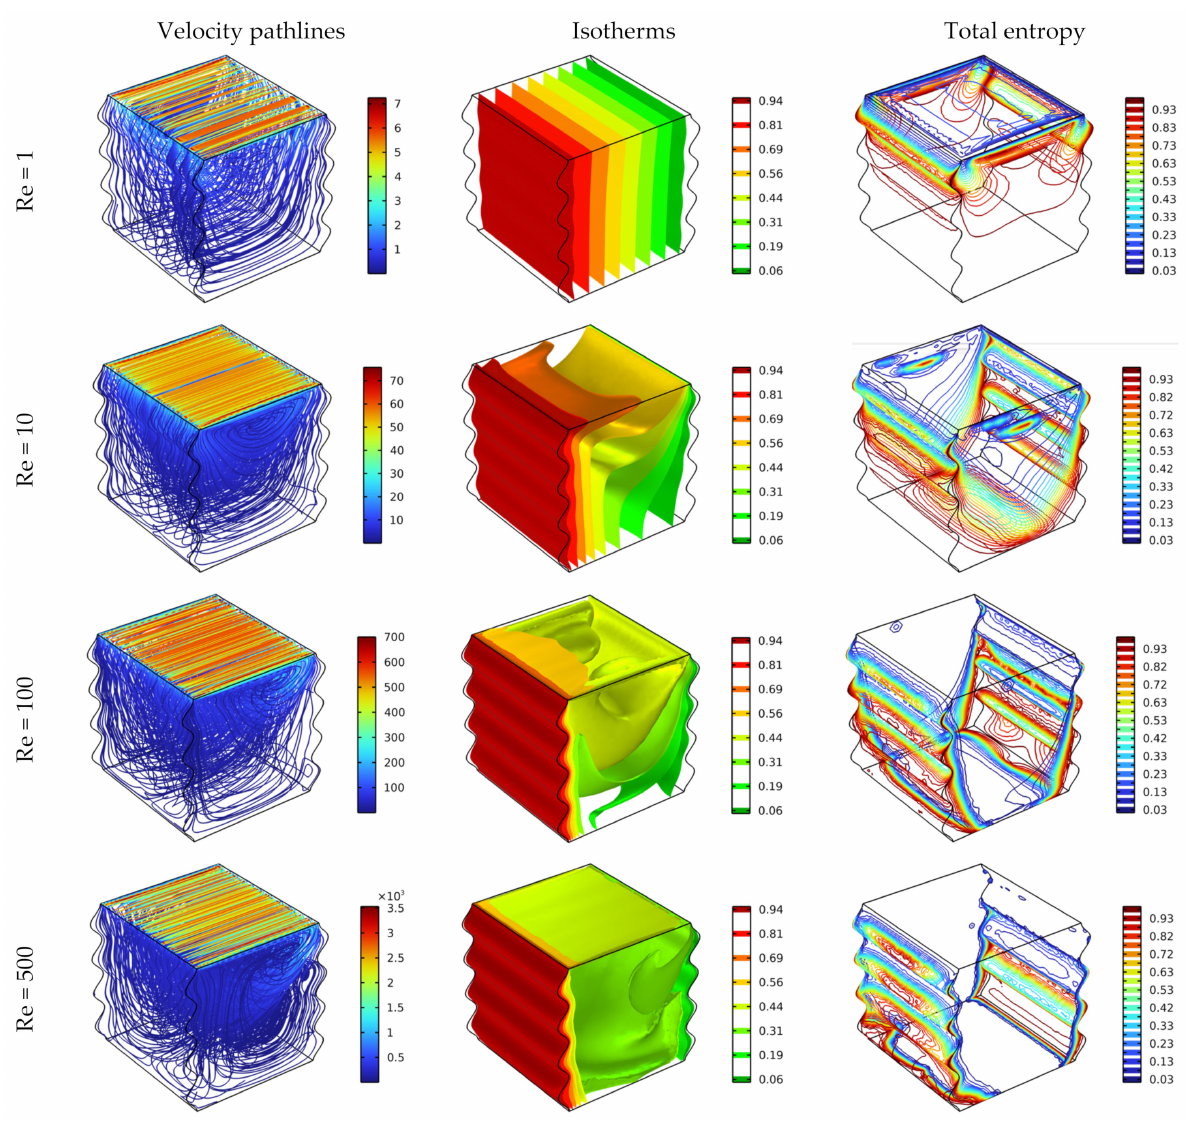
Figure 6. Distribution of streamlines, isotherm, and total entropy for different Re for Ha = 0, Da = 10 –2 , and ϕ = 0.04. Figure 7A present the evolutions of the Nu avg and Bejan numbers when applying different values of Hartman and